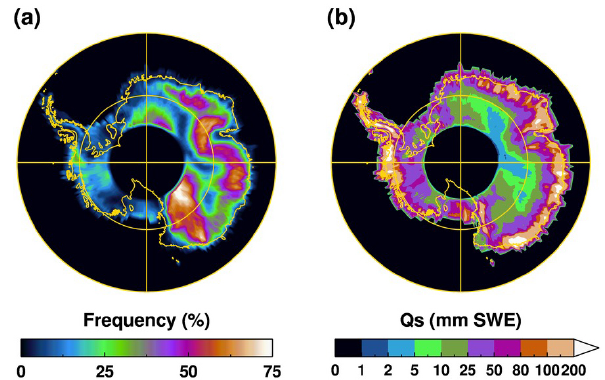
Figure 3. (a) The average April through October blowing snow fre- quency for the period 2007–2015. (b) The average annual blowing snow sublimation for the same period as in (a) .